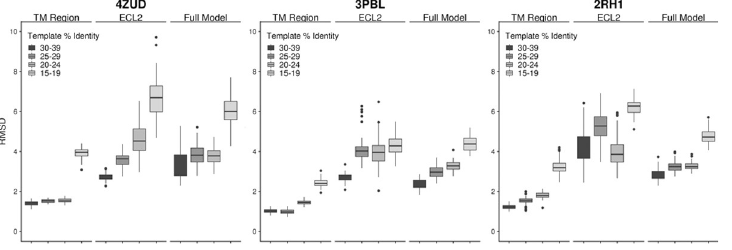
Fig 6. Model accuracy with templates over multiple sequence identity ranges. Three receptors (4ZUD [43], 3PBL [44], and 2RH1 [5]) were identified that had at least 5 templates in each identity range (30–39%, 25–29%, 20–24%, and 15–19%). Using the identified 5 templates for each identity range, 100 models were generated and the RMSD of these models is displayed in box and whisker plots for each region (TM, ECL2, and Full